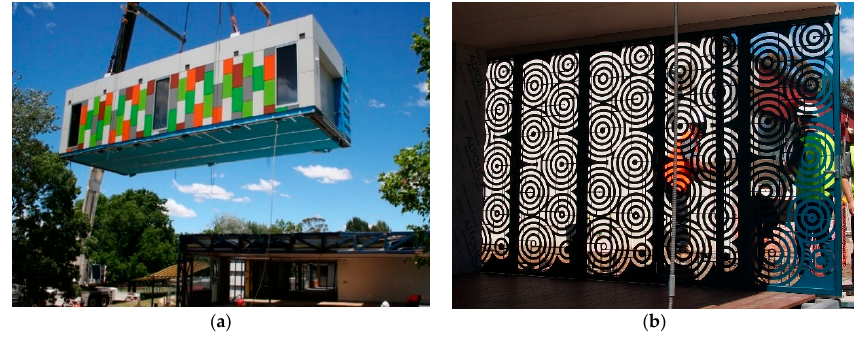
Figure 2. Duffy Primary School 2013 ( a ) under construction; ( b ) detail of modules. Images: S.B.